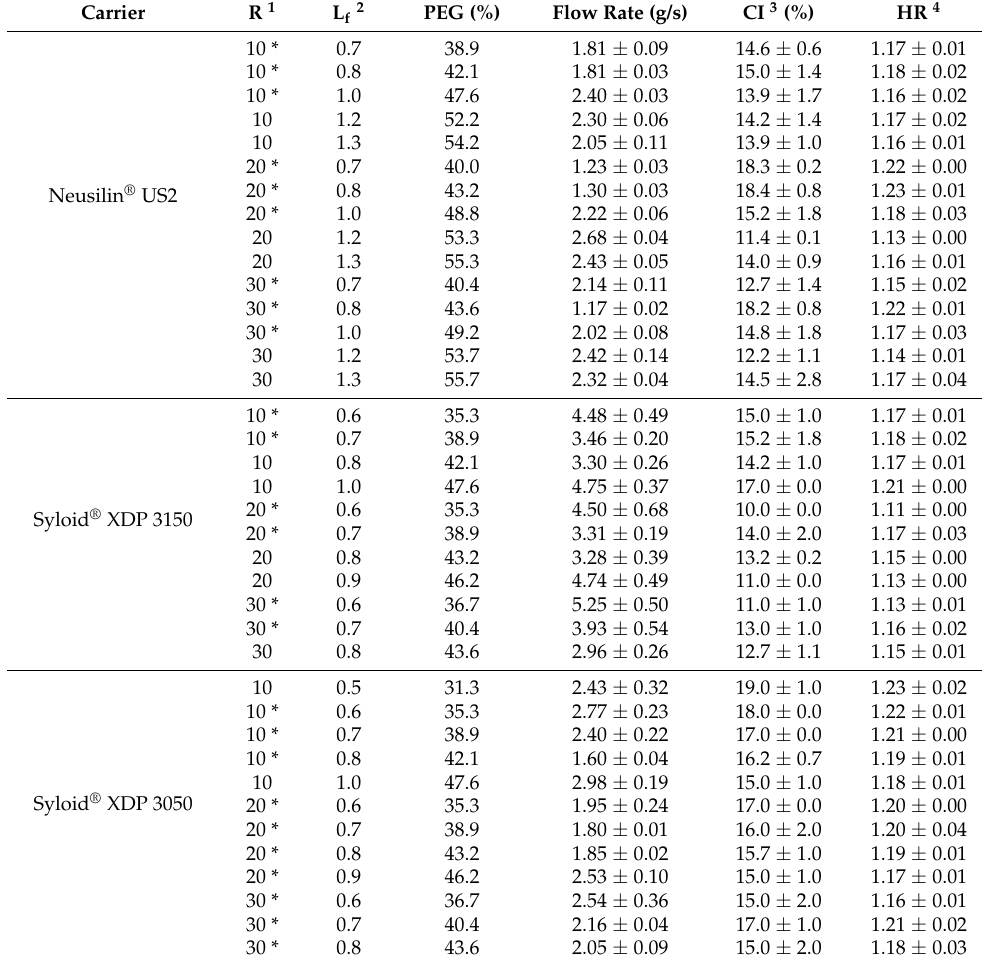
Table 1. Composition of prepared LS admixtures and their flow